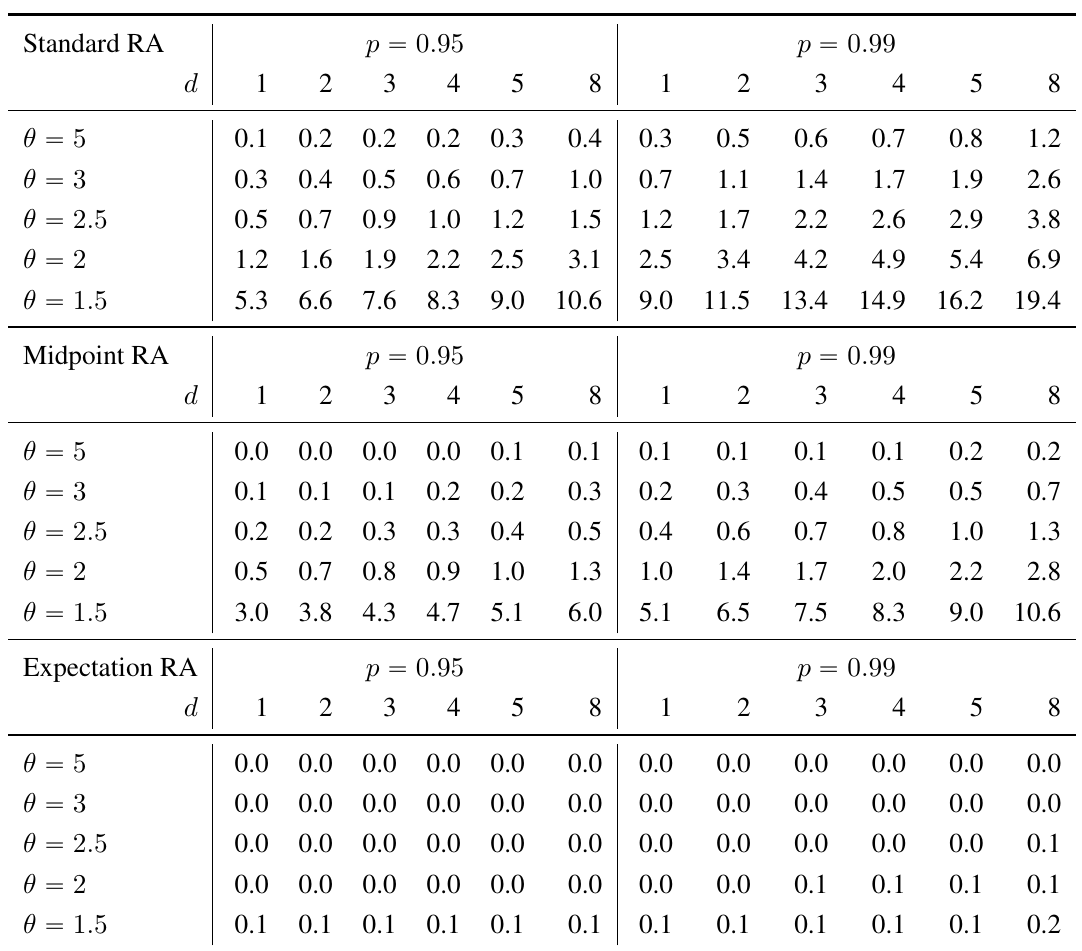
Table 1. Relative underestimation as a percent of the exact ES using the rearrangement algorithm (RA) with different discretizations of size N “ 10 5 and stopping condition ε “ 10 ´ 4